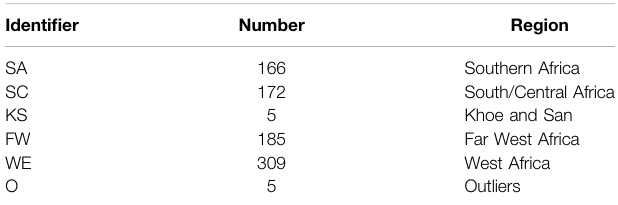
TABLE 2 | Clusters within Africa, including the number of individuals in each cluster. Clusters include both HAAD and 1,000 Genomes African population